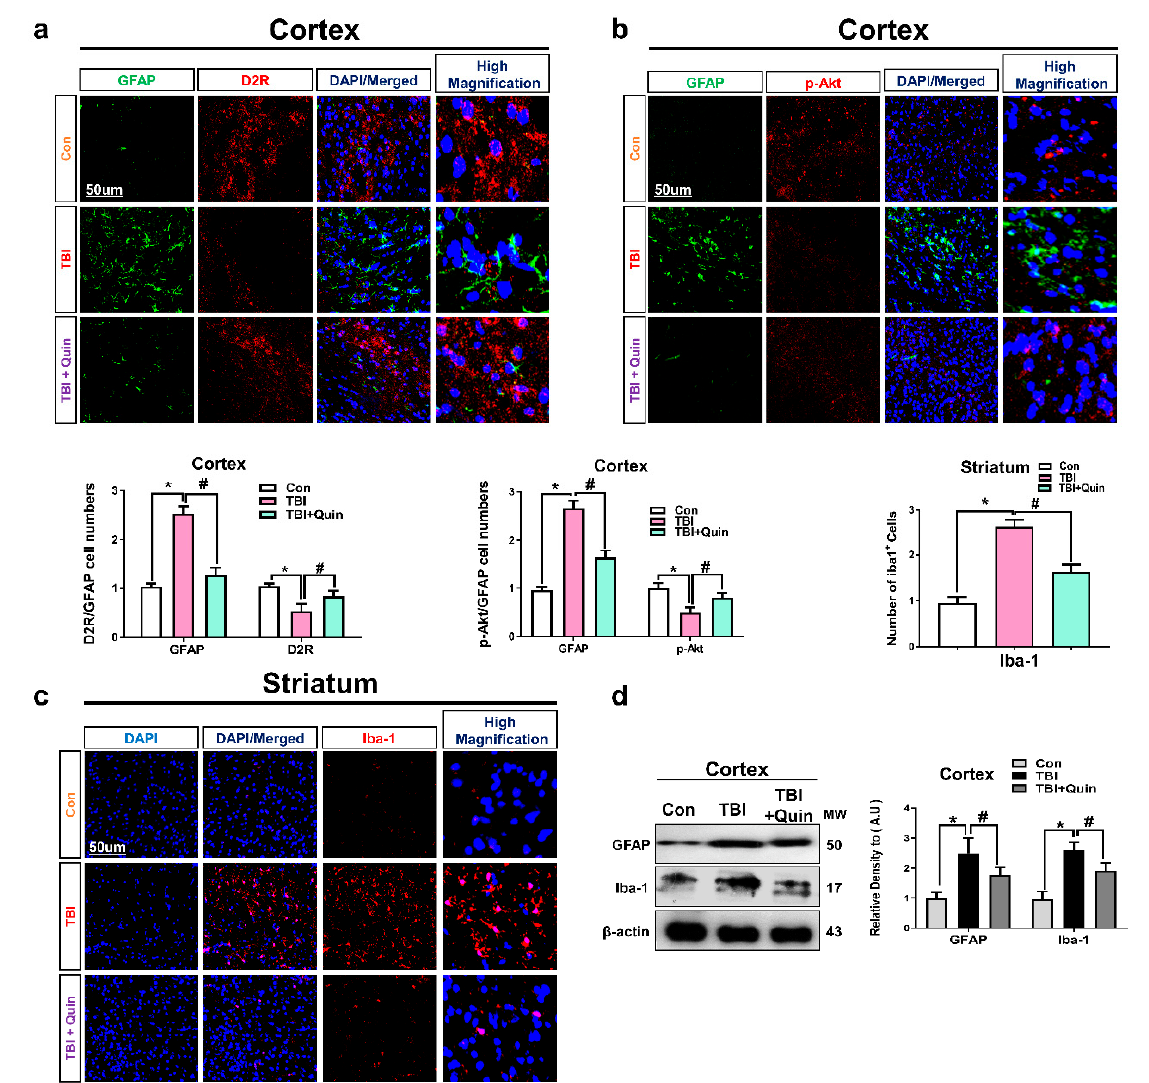
Figure 3. Quinpirole reduces astrocyte and microglia activation after brain injury. ( a ) Representative confocal microscopy images showing double immunoreactivity of GFAP and D2R expression level in ipsilateral cortex of TBI mouse model. ( b ) Images of double immunoreactivity of GFAP and p-Akt expression level in ipsilateral cortex of TBI mouse model (green, FITC; red, TRITC; blue, DAPI). ( c ) Confocal images of Iba-1 in ipsilateral striatum of brain-injured and quinpirole-treated mice, with respective bar graphs, (magnification × 10, n = 6). ( d ) Images of Western blot and histogram analysis showing GFAP and Iba-1 expression levels in ipsilateral cortex of brain-injured and quinpirole-treated mice. The β -actin was used as a loading control ( n = 5). The ImageJ software was used for immunohistological analysis and the number of GFAP and iba-1 cells were quantified that containing D2R and p-Akt in the representative field. Data were obtained following three independent experiments. The ImageJ software was used for quantitative analysis of the confocal microscopy images. Values are expressed as mean ± SEM. We performed the one-way ANOVA test followed by post-hoc analysis. A p value < 0.05 was considered statistically significant. * significantly different between the control and brain injury groups, # significantly different between the brain injury and quinpirole-treated groups. ANOVA: analysis of variance, GFAP: glial fibrillary acidic protein, Iba-1: ionized calcium binding adaptor molecule 1, SEM: standard error of mean.